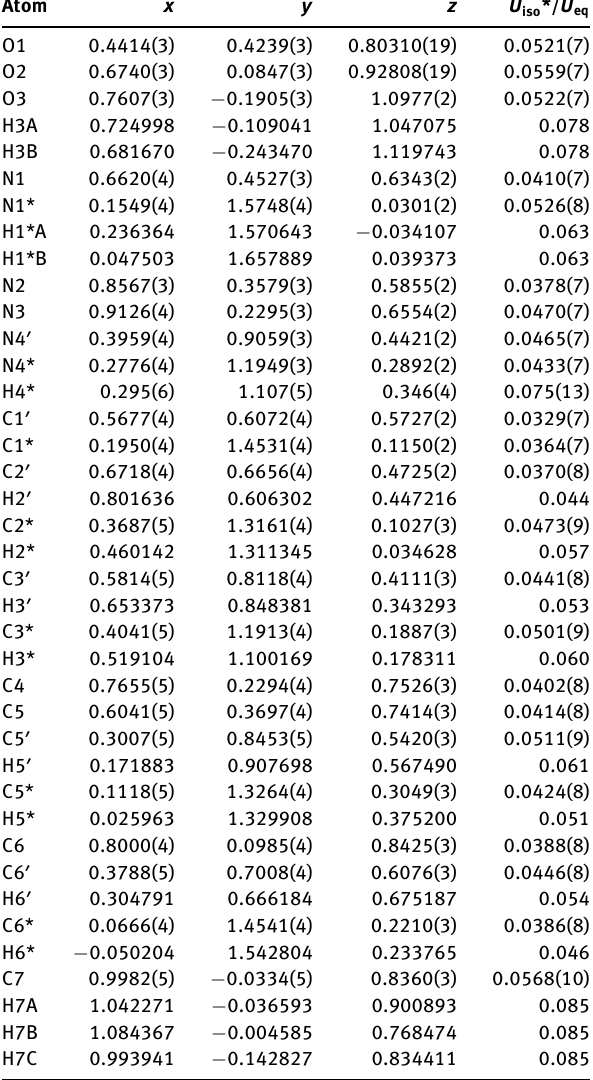
Table 2: Fractional atomic coordinates and isotropic or equivalent isotropic displacement parameters (Å 2